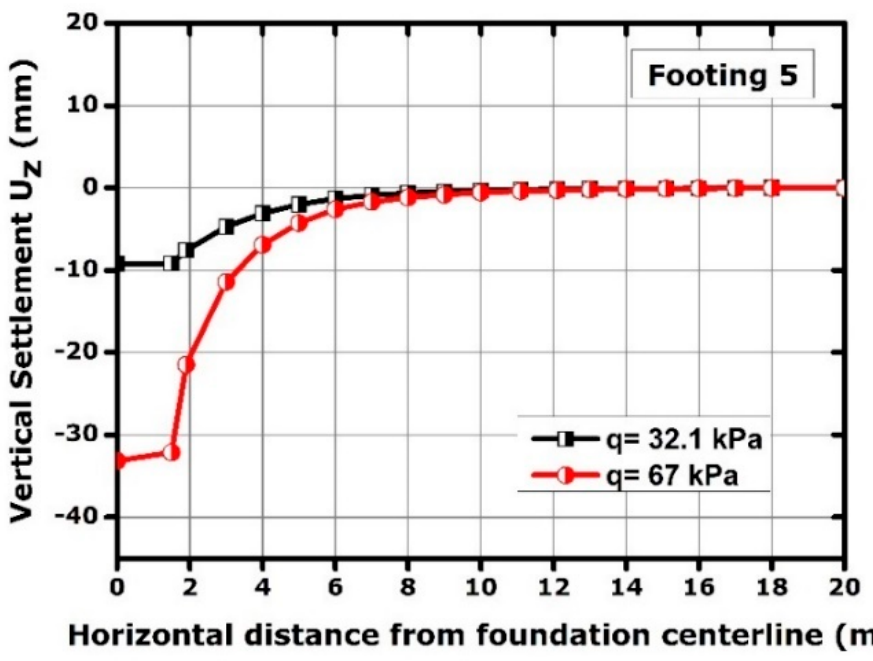
Figure 12. Influence of column length on the footing and ground surface settlement in drained conditions—Footing 5.